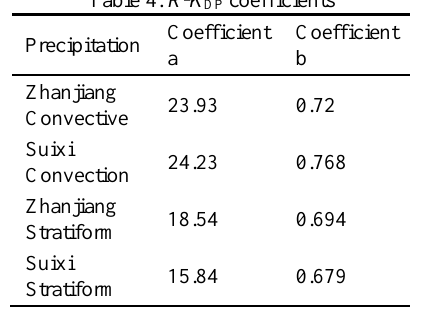
Table 4. R - K DP coefficients